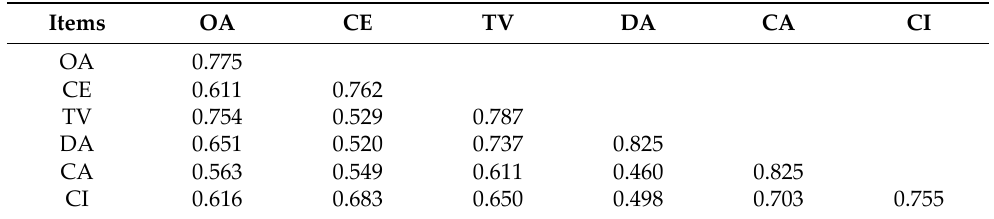
Table 4. Discriminant